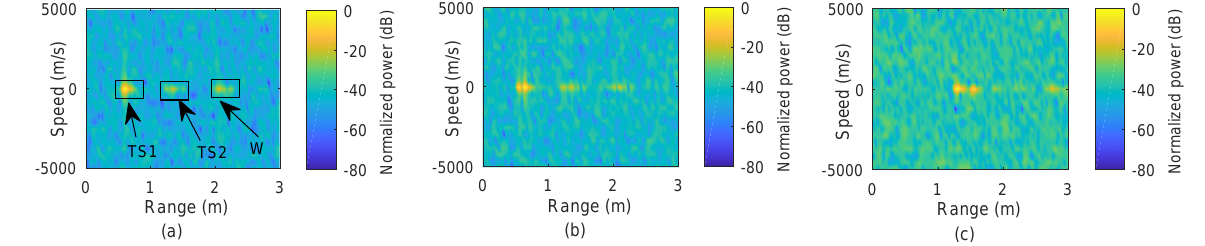
Figure 8. Measurement results for different arrangements of static targets. ( a ) Range plot of a target when placed at 0.6 m. ( b ) Range plot for two targets placed at 0.65 m and at 0.6 m. ( c ) Results of two targets placed at 1.313 m and at 1.548 m, respectively.